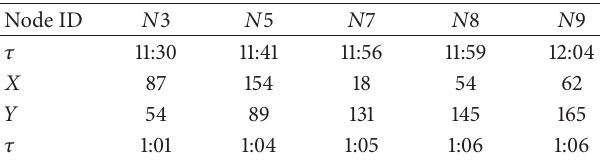
Table 2: 𝑖𝑅𝑂𝑈𝑇𝐼𝑁𝐺 𝑡𝑎𝑏𝑙𝑒 .